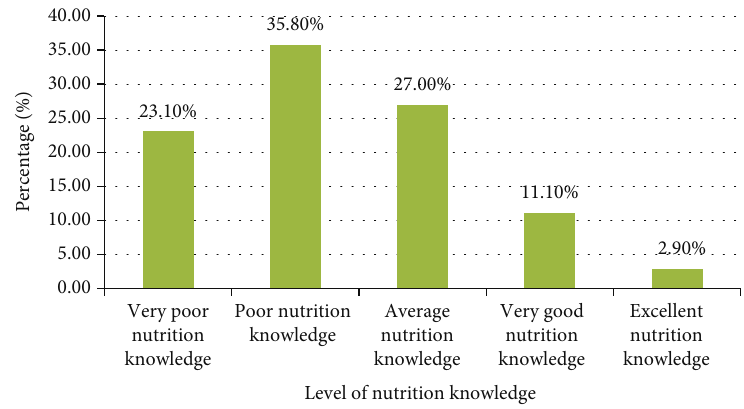
Figure 5: Nutrition knowledge score of mothers/caregivers of the